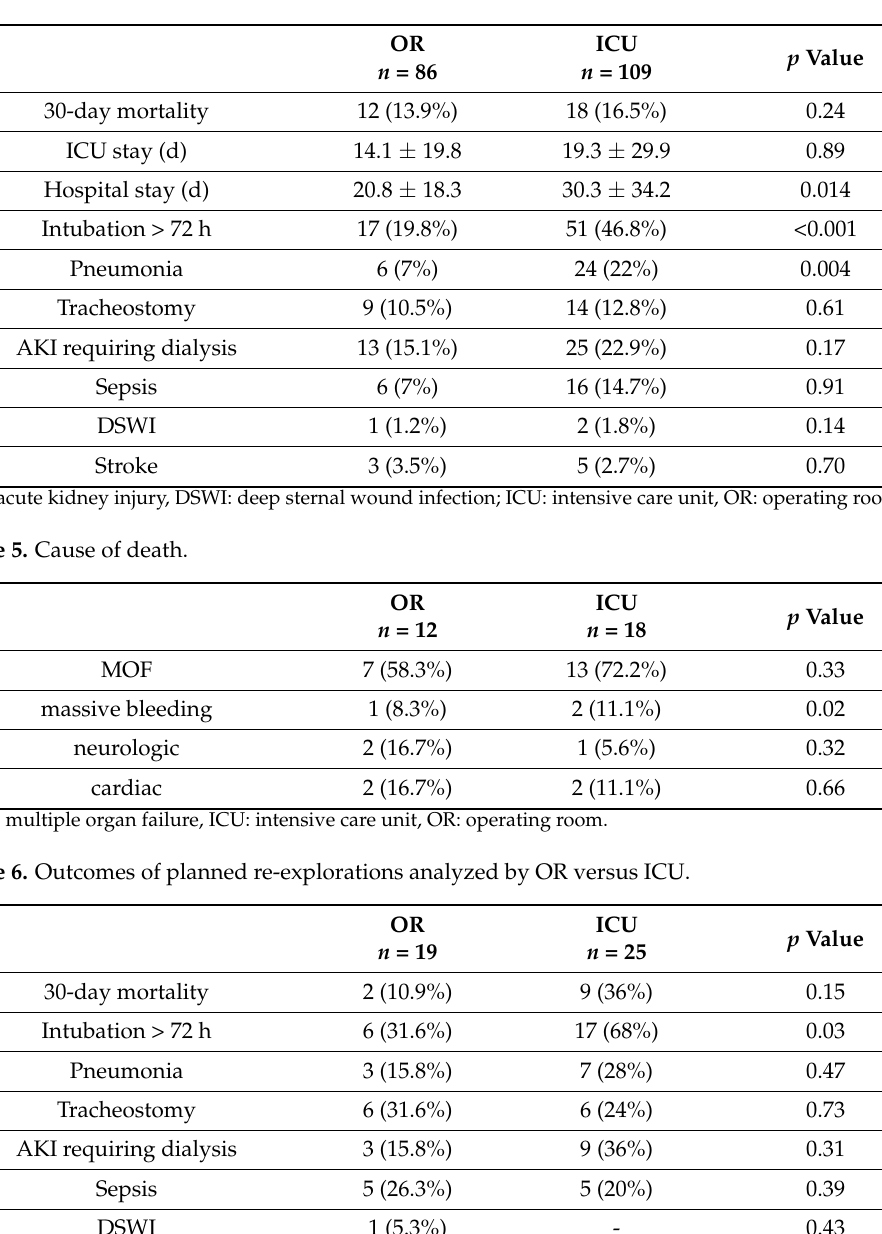
Table 4. Outcomes.